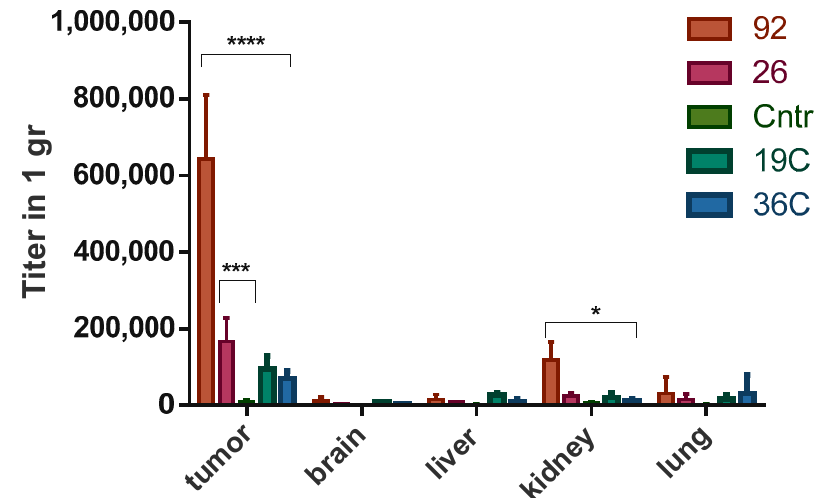
Figure 4. Comparative analysis of the distribution and specificity of accumulation in the U-87 MG xenograft Table 92, 26, 19C and 36C displayed peptides HPSSGSA, SWTFGVQFALQH, MHTQTPW, ISYLYGR, respectively, and the control bacteriophage displaying the peptide YTYDPWLIFPAN (control). The average titer of bacteriophages (pfu/1 g of tissue) obtained from the tumor and control organs (liver, brain, kidney and lungs). Data are presented as mean ± standard deviation. Multiple comparison was performed using two-way ANOVA. * p ≤ 0.05; *** p ≤ 0.001; **** p ≤ 0.0001.